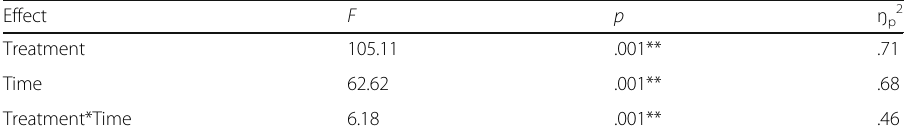
Table 7 The results of repeated measures ANOVA for the narrative writing task and text summary